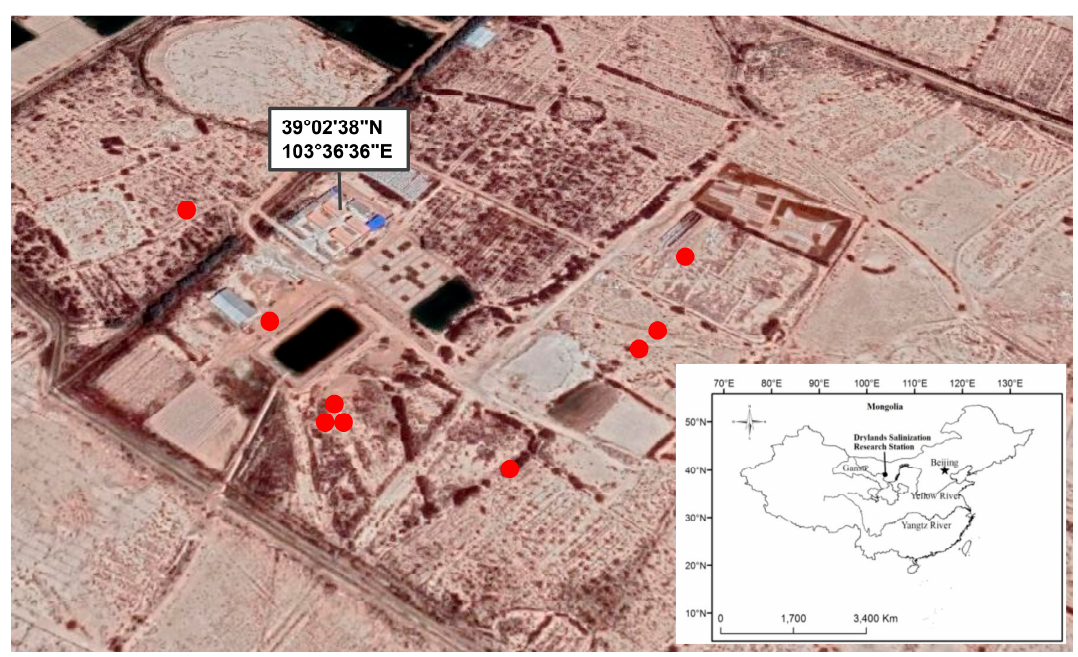
Figure 1. Study area. Red dots represent the sampling points (Landsat imagery, Google Earth).